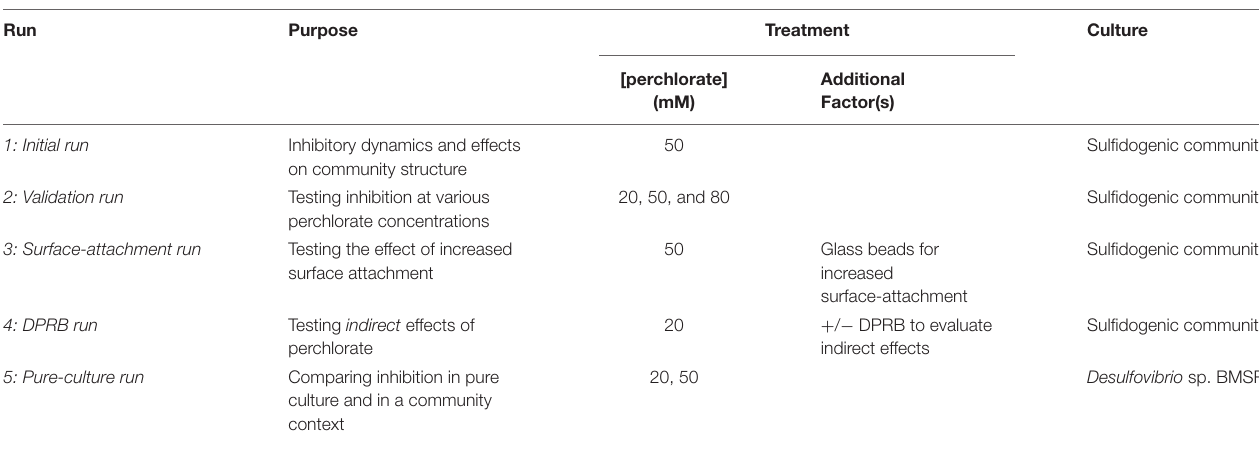
TABLE 1 | Summary of chemostat